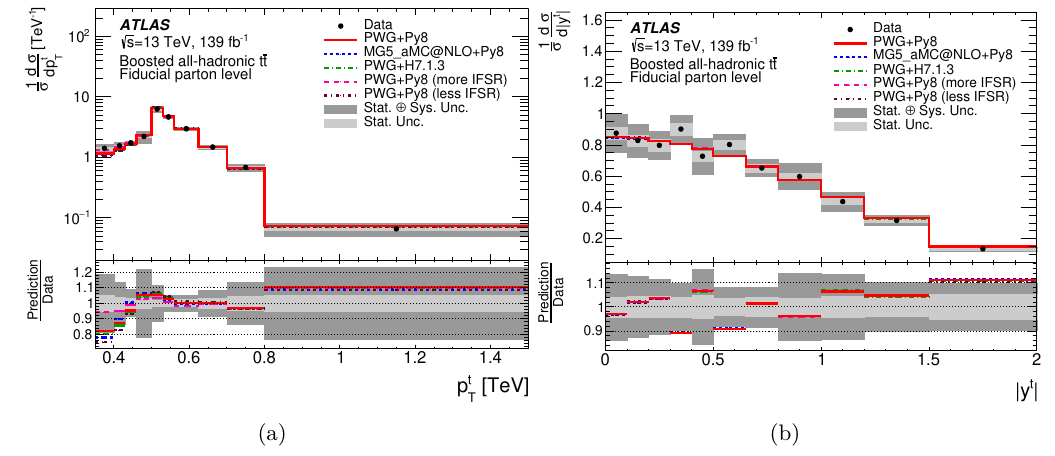
Figure 44 . Normalized parton-level fiducial phase-space differential cross-sections as a function of (a) the transverse momentum and (b) the absolute value of the rapidity of the randomly chosen top quark. The dark and light grey bands indicate the total uncertainty and the statistical uncertainty, respectively, of the data in each bin. Data points are placed at the centre of each bin. The Powheg+Pythia 8 MC sample is used as the nominal prediction to correct the data to parton